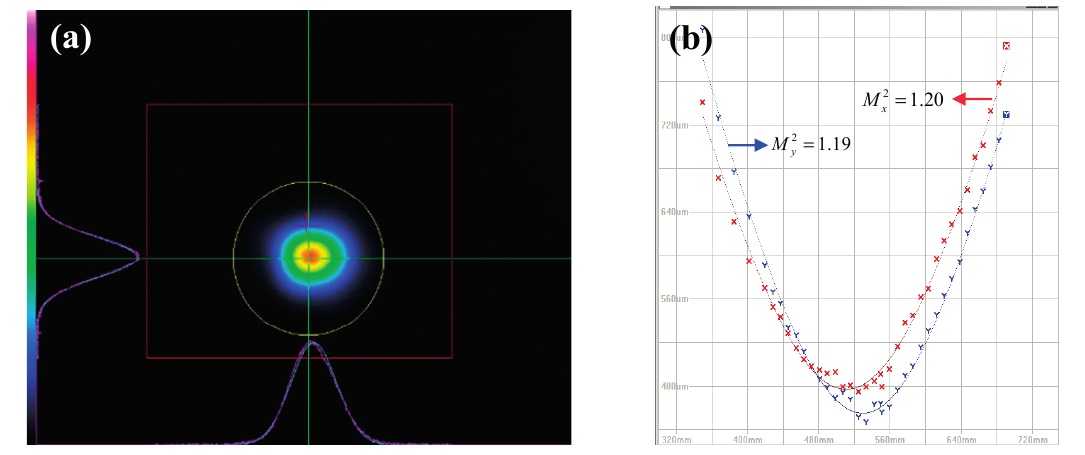
Figure 8. Measured beam characteristics of ( a ) profile of the output with x direction 1.5 mm and y direction 1.3mm; ( b ) M 2 with 2 1.20